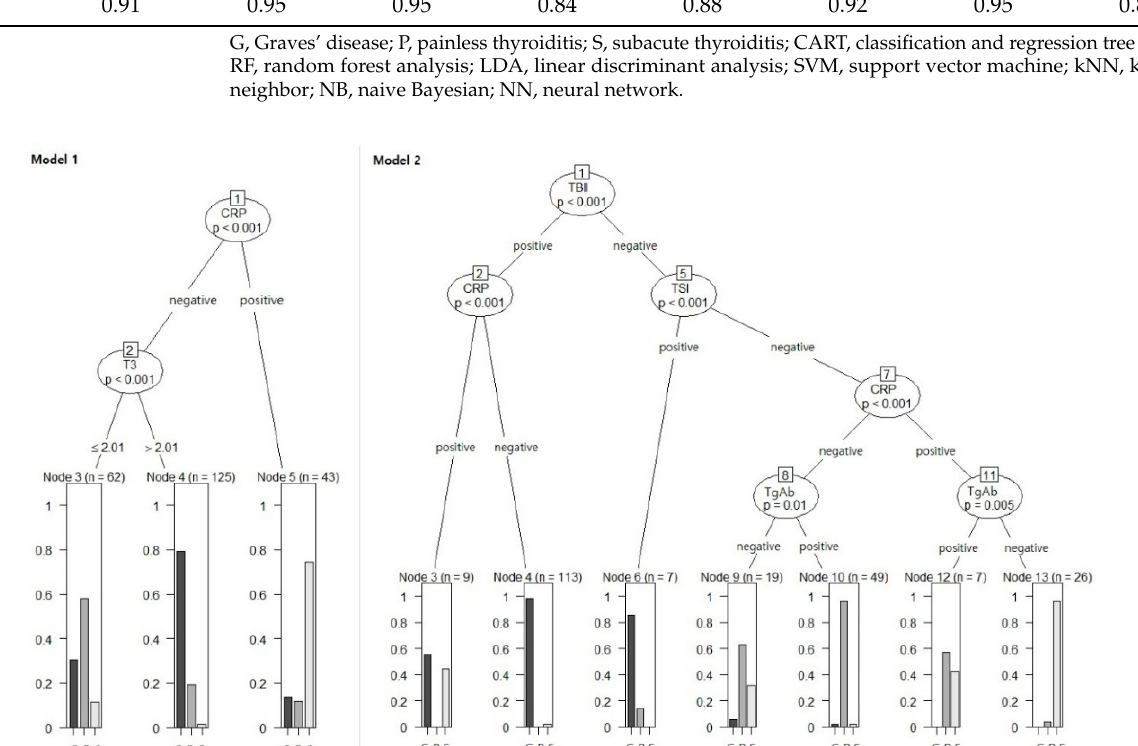
Figure 4. Variable importance plot for the random forest algorithm calculated using the impurity method for Model 1 and Model 2.